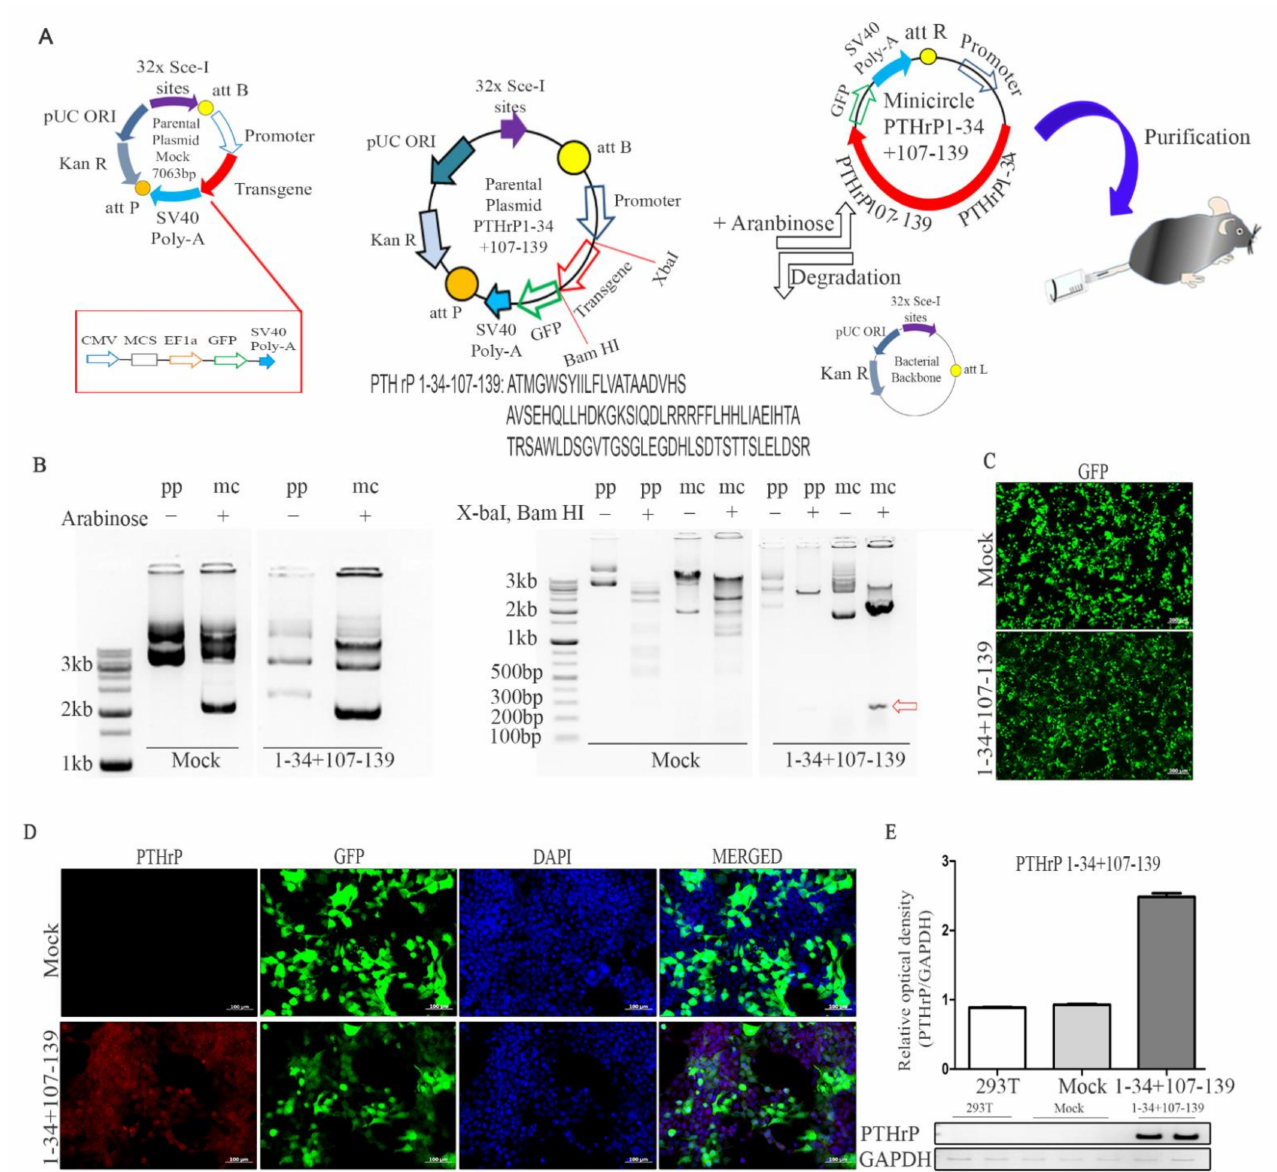
Figure 1. Production of the mc PTHrP 1–34+107–139 vector. ( A ) Schematics of the approach used for the generation of the mc PTHrP 1–34+107–139. ( B ) Representative agarose gel images of the parental (pp) and minicircle (mc) vectors and of the insertion confirmation after double digestion with restriction enzyme, XbaI, and Bam HI. ( C ) Fluorescence image of green fluorescence protein (GFP) expression in HEK 293T cells 48 h post-transfection with the mc PTHrP 1–34+107–139 vector; scale bar = 200 µ m. ( D ) Immunofluorescence images showing the expression of PTHrP (red) and GFP in HEK 293T cells; scale bar = 100 µ m. ( E ) Detection of the expression of PTHrP 1–34+107–139 (normalized to that of GAPDH ) in a HEK 293T cell lysate, 48 h